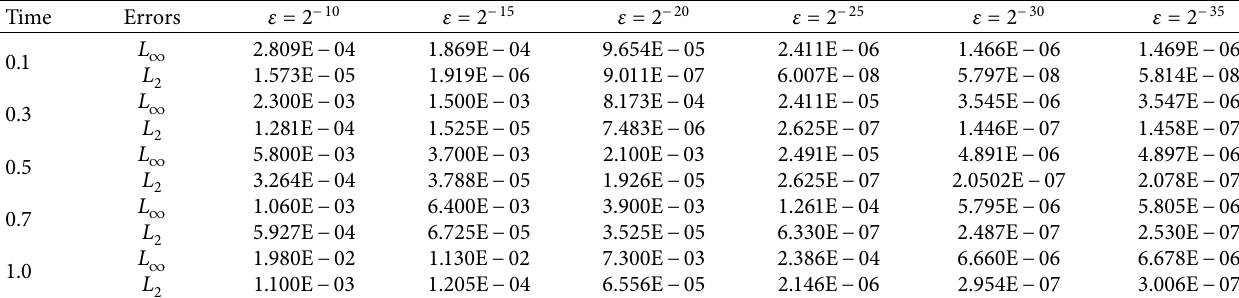
and L errors at different times and parameters with M � 150 , n s � 3. ∞ 2